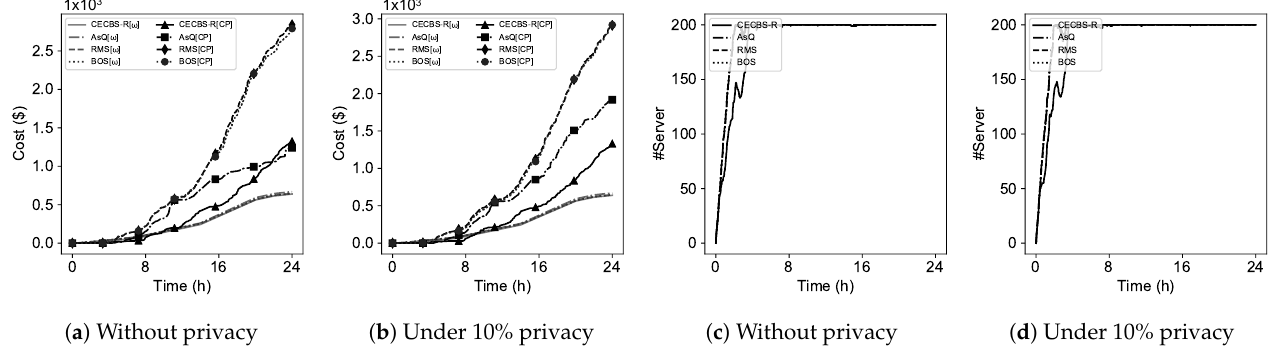
Figure 15. The accumulated edge ( ω ) and public cloud ( CP ) cost followed by the edge server usage for ∼ 24.4 k